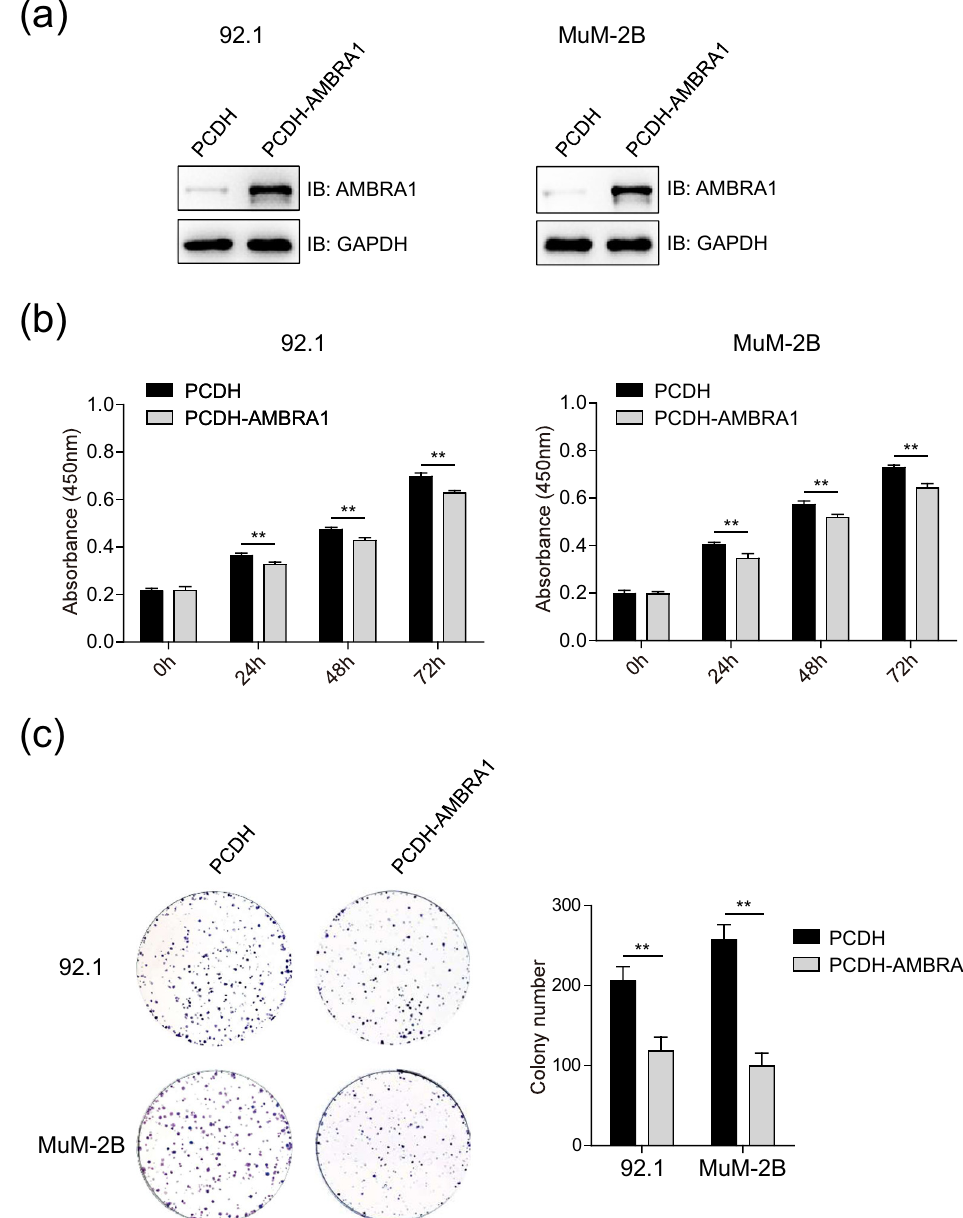
Figure 3: AMBRA1 inhibits the proliferation of UVM cells. ( a ) The protein levels of AMBRA1 in UVM cells stably expressing AMBRA1 were detected by immunoblotting analysis. MUM - 2B and 92.1 cells were transfected with empty vector PCDH or PCDH - AMBRA1, and then puromycin ( 5 µg/mL ) selection was used to establish stably expressing cell lines. ( b ) AMBRA1 inhibits the proliferation of UVM cells. MUM - 2B and 92.1 cells stably expressing PCDH empty vector or PCDH - AMBRA1 were seeded into 96 - well plates, and the cell viability was detected by the CCK - 8 assay at the indicated time points. ** P < 0.01, very signi fi cantly di ff erent, three independent experiments. ( c ) AMBRA1 inhibits the colony formation of UVM cells. MUM - 2B and 92.1 cells stably expressing empty vector PCDH or PCDH - AMBRA1 were seeded into six - well plates, and the colonies were fi xed and stained. The images were captured using a camera, and the colony numbers were counted and calculated. The data were expressed as mean ± SD and analyzed using one - way ANOVA with Tukey ’ s post hoc test. ** P < 0.01, very signi fi cantly di ff erent, three samples for each